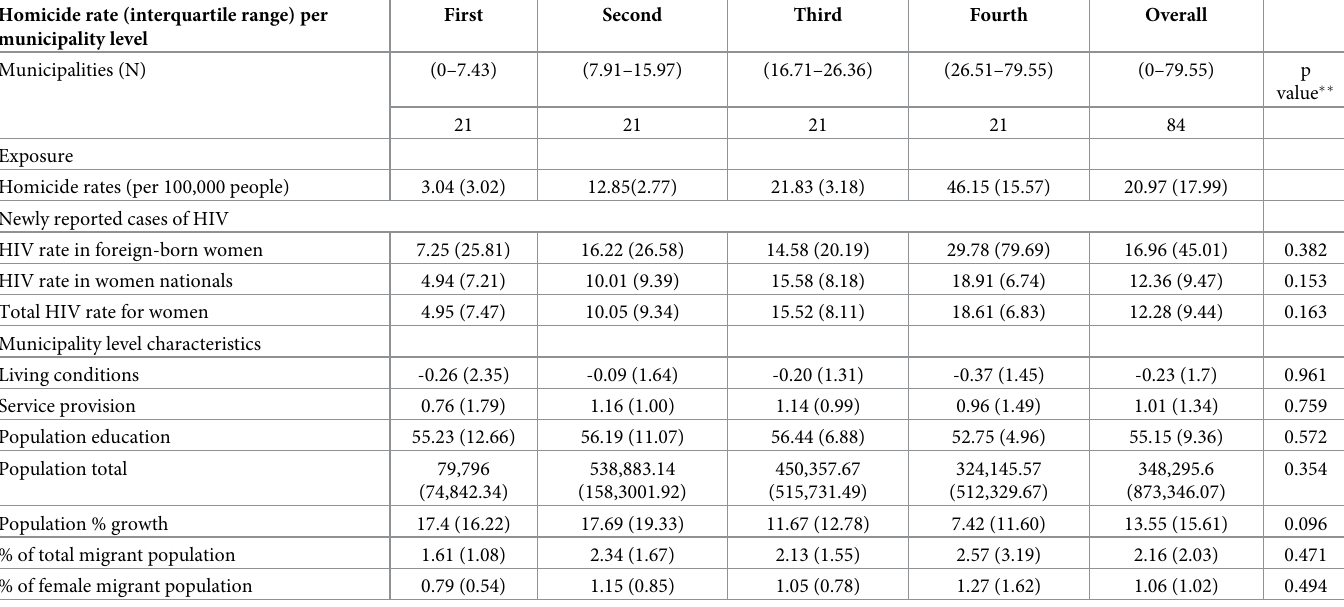
� Figures in this table correspond to mean rates and SD for the exposure, dependent variable and across municipalities in each quartile. �� P-values were estimated using ANOVA test with HR as the independent variable, reflecting bivariate